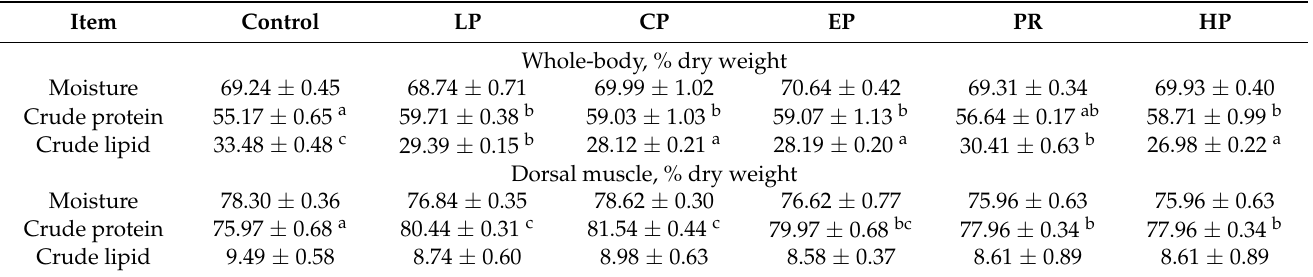
Table 7. The whole-body and muscle composition of Oncorhynchus mykiss fed with the experimental